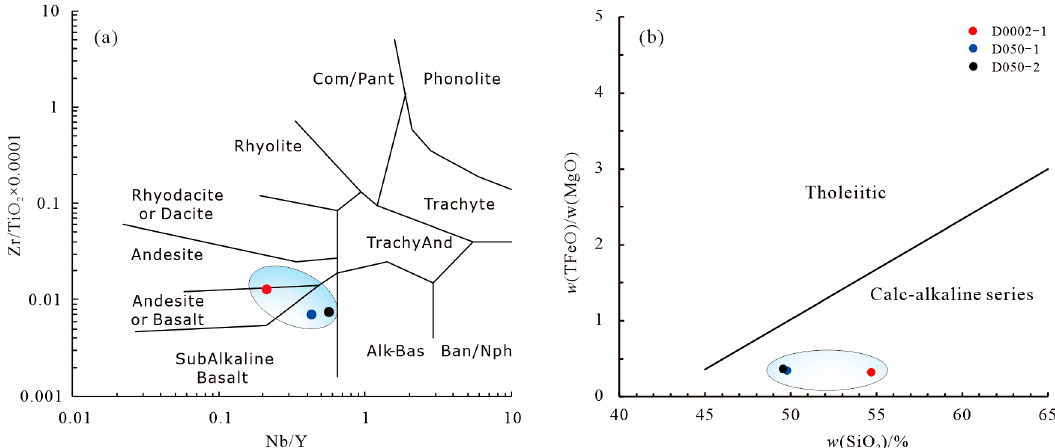
Figure 15. ( a ) Classification of the biotite–tremolite schist enclaves from the Kongling Terrane using the Nb/Y vs. Zr/Ti diagram after [31] and modified by [32] and ( b ) TFeO/MgO vs. SiO 2 diagram after [33].